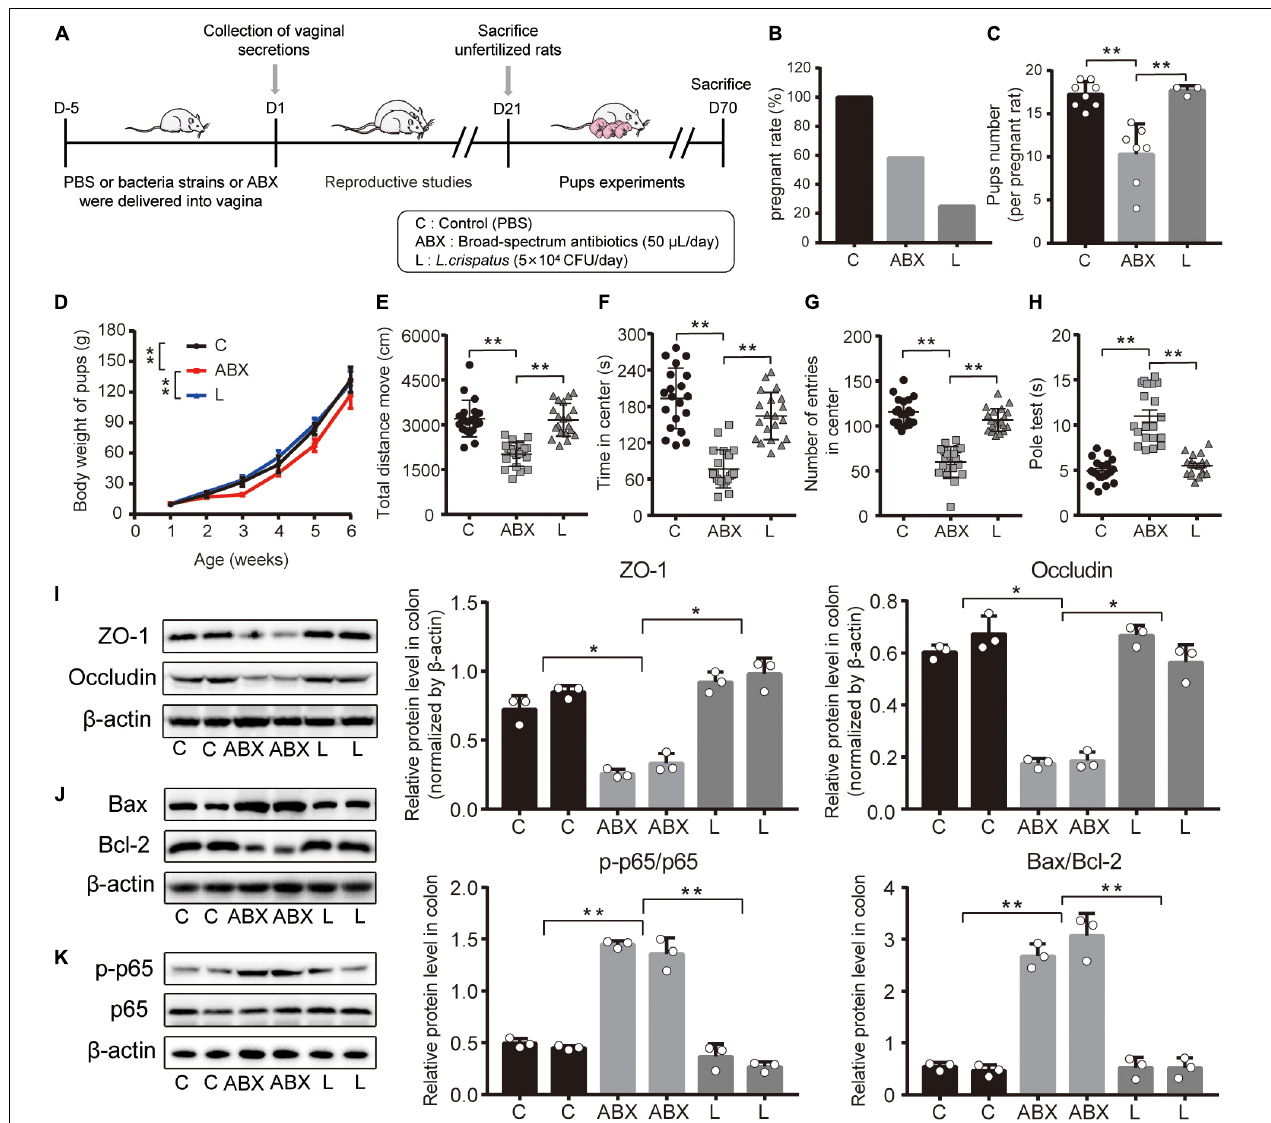
FIGURE 6 | Treated vagina with L. crispatus had no reproductive and developmental toxicity on maternal and offspring rats. (A) Scheme of experimental timeline and procedures. (B) Fertility outcomes about pregnancy rates and (C) number of pups from the female rats of the indicated treatment groups. (D) Comparison of the body weight of pups among C, ABX, and L groups from P 7 to P 42. (E) Total moving distance in the open-field test. (F) The time of pups in center total moving distance in the open-field test. (G) The number of entries in the center in the open-field test. (H) The time of pups climbing pole in the pole test. (I) Expression level of intestinal tight junction proteins, ZO-1, and Occludin. (J) Protein expression level of apoptosis-associated factors, Bcl-2 and Bax. (K) Protein expression level of p-p65 and p65. The data represent means ± SD of eight to 20 animals or three independent experiments. * P < 0.05, ** P < 0.01. SD, standard deviation; C, control; ABX, wide-spectrum antibiotic; L, L. crispatus